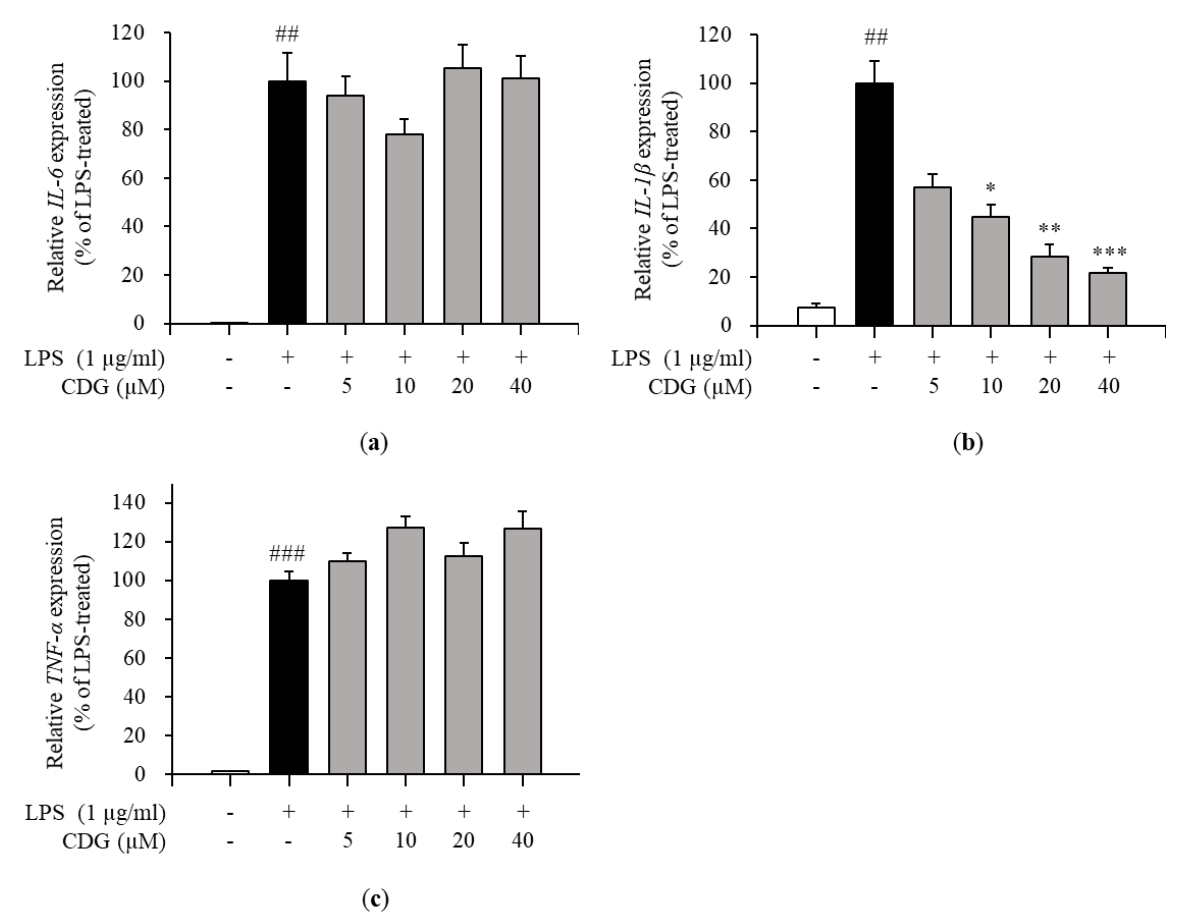
Figure 4. Effect of CDG on pro-inflammatory cytokine mRNA expression. The ImKC cells were treated with CDG (5, 10, 20, and 40 µ M) for 2 h and stimulated by LPS (1 µ g/mL) for 3 h. After LPS treatment, the mRNA expression of pro-inflammatory cytokines, such as ( a ) IL-6, ( b ) IL-1 β , and ( c ) TNF- α , were compared with the LPS-treated group set at 100%. The mRNA levels of the pro-inflammatory cytokines are shown via a bar graph. Data are represented as the mean ± standard deviation. ## p < 0.01 and ### p < 0.001 relative to the untreated control group. * p < 0.05, ** p < 0.01, and *** p < 0.001 relative to the LPS-treated and CDG-untreated group. CDG, catechin-7,4 (cid:48) - O -digallate; LPS, lipopolysaccharide; IL, interleukin; TNF, tumor necrosis factor.